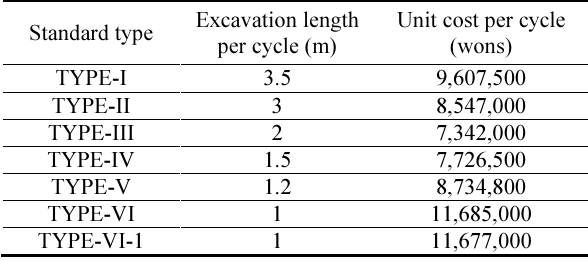
Table 1. Type-based unit costs used in Samtan 1 Tunnel